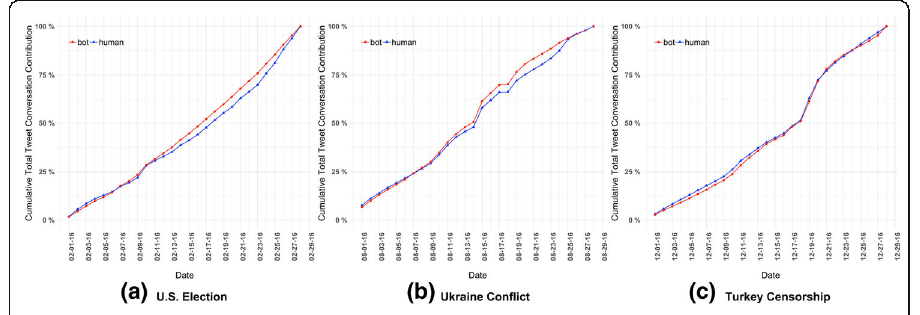
Fig. 2 Cumulative total tweet contributions over the four-week Twitter conversation span for: a U.S. Election (February 1 – 28, 2016), b Ukraine Conflict (August 1 – 28,2016), c Turkish Censorship (December 1 – 28,